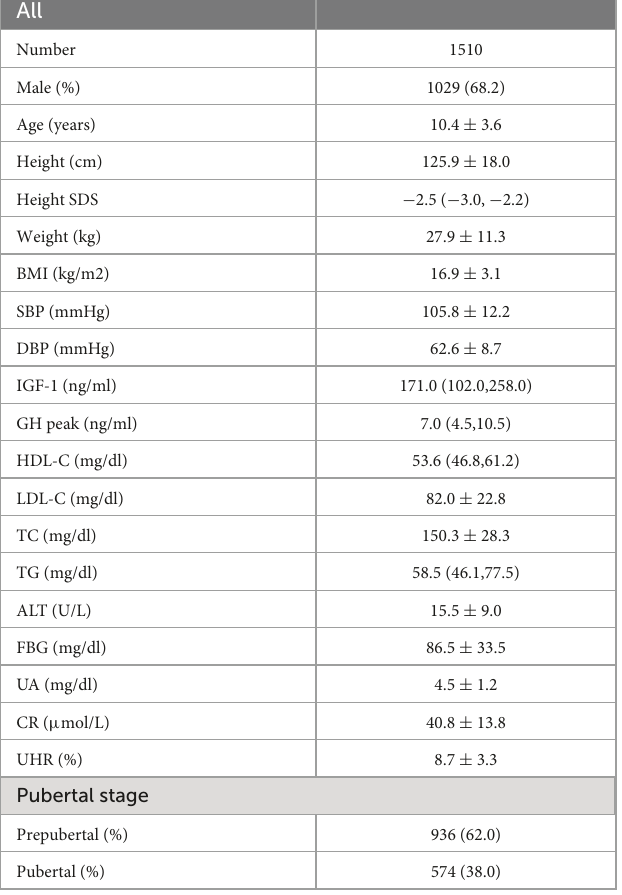
TABLE 1 Study population